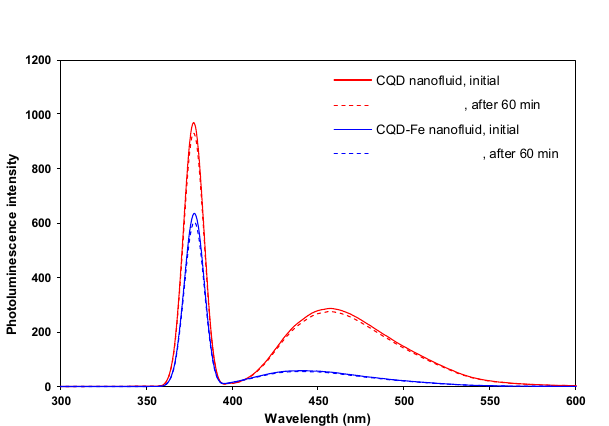
Figure 3. Photoluminescence spectra of CQD and CQD-Fe nanofluids just after preparation and after 60 min.